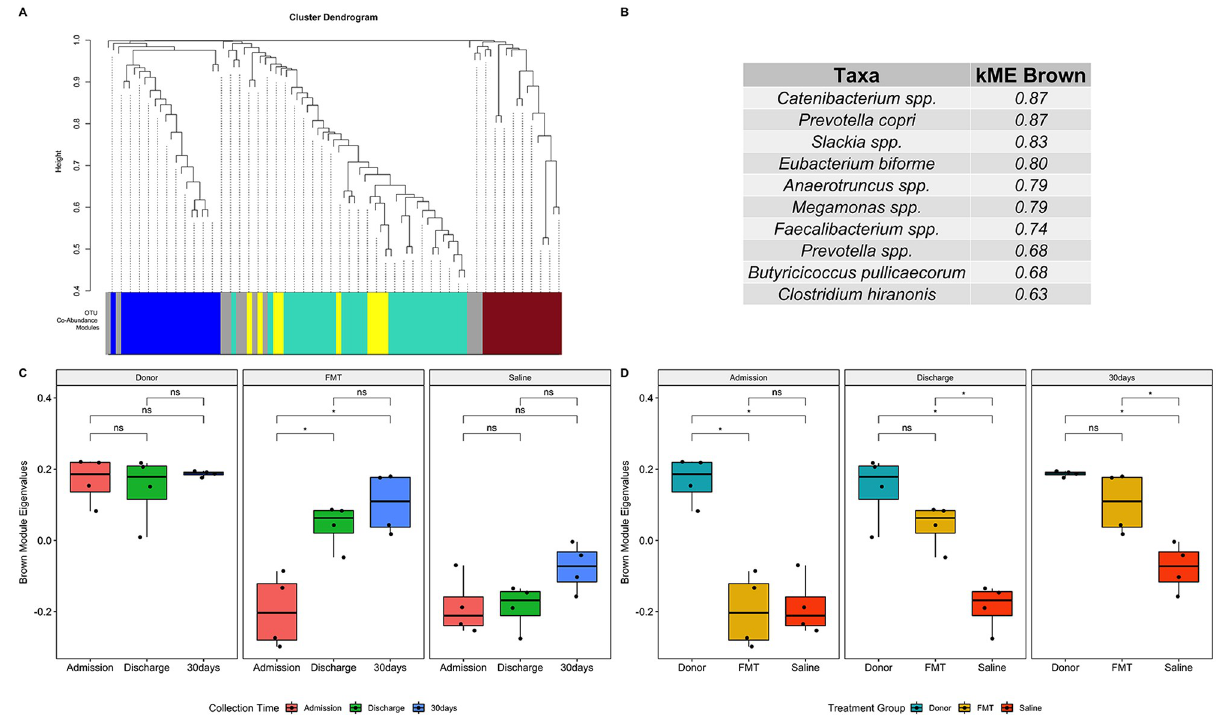
Fig 8. Weighted co-abundance analysis identified a subnetwork of bacteria significantly associated with FMT. A weighted co-abundance network was generated to identify subnetworks (modules) of taxa associated with FMT. Module eigen-OTUs (a mathematical summary of module abundance derived from principal component analysis) were used to detect differences in module abundance among treatment groups and collection times. (A) A cluster dendrogram of OTUs with correlated patterns of abundance. The OTUs were grouped into 6 modules and represented by an arbitrarily unique color below the dendrogram. OTUs that were not grouped into a co-abundance module are represented by the gray color. (B) The “Brown” module was found to contain the same taxa that were differentially abundant in post-FMT samples. The importance of each OTU within the “Brown” module was quantified by the module eigen-OTU connectivity (kME), also known as module membership. As the kME of a given OTU approaches 1, it more closely characterizes the abundance pattern of the whole module. OTUs with kME > 0.5 are shown. (C) The “Brown” module was increased at discharge and 30 days in FMT recipients but was unchanged in sham-treated controls. (D) “Brown” module abundance was decreased in the FMT and sham-treated control groups at admission. The “Brown” module increased in abundance in FMT recipients at discharge and 30 days, compared with sham-treated controls. There were no statistically significant differences in “Brown” module abundance between donors and FMT-recipients at discharge or 30 days. Statistical comparisons among treatment groups and collection times are indicated by annotated brackets where “ns” represents P � 0.05 and “ � ” represents P 0.01 < P < 0.05. FMT: fecal microbial